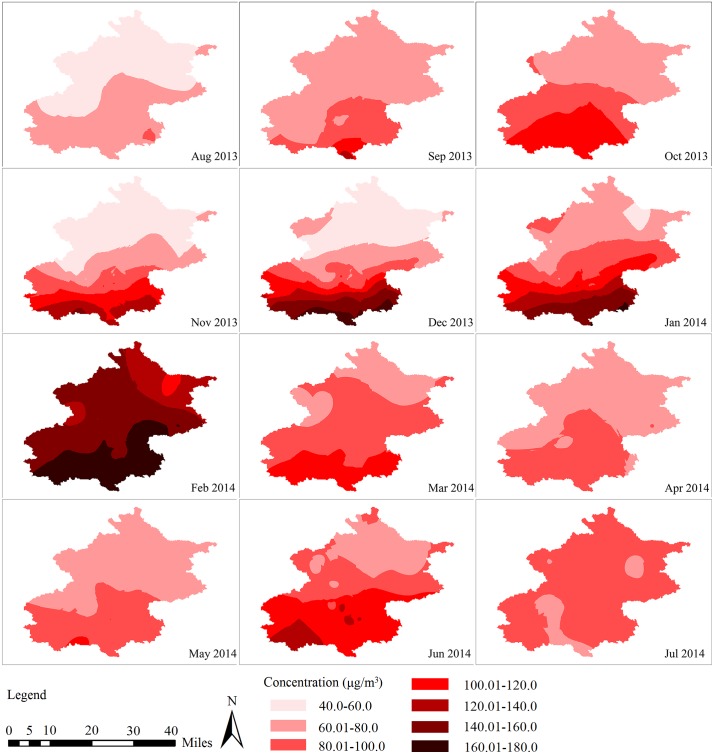
Regional and seasonal variations of PM2.5 in Beijing, 2013–2014.